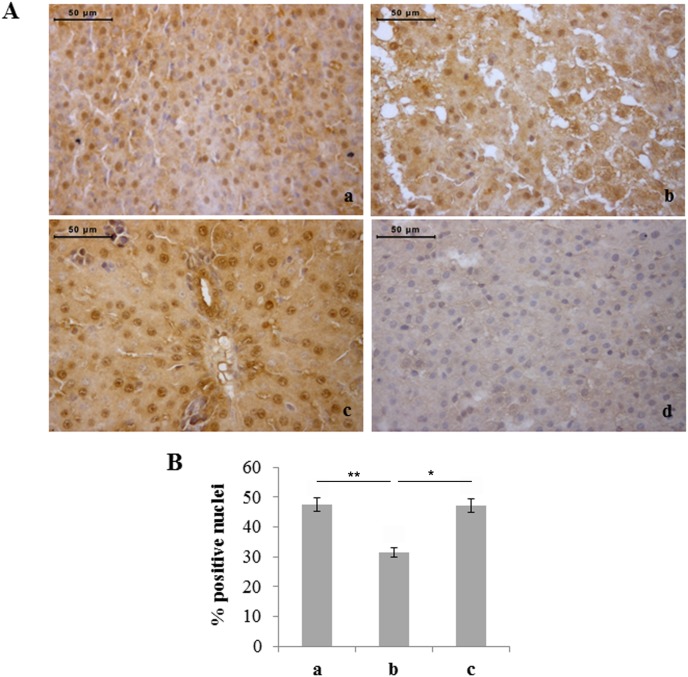
Moderate hyperoxia reduces the number of NF-kB positive hepatocytes with respect to normoxia and severe hyperoxia.A) Immunohistochemical detection of Nfκb expression in neonatal rat livers exposed to moderate and severe hyperoxia. a) ambient air; b) 60% hyperoxia; c) 95% hyperoxia; d) negative control; scale bar: 50 µm, magnification 40x. B) Graphic representation of the percentages of NF-kB positive nuclei (±SD); densitometric analysis determined by direct visual counting of ten fields for each of three slides per sample. * = p<0.05; ** = p<0.01.